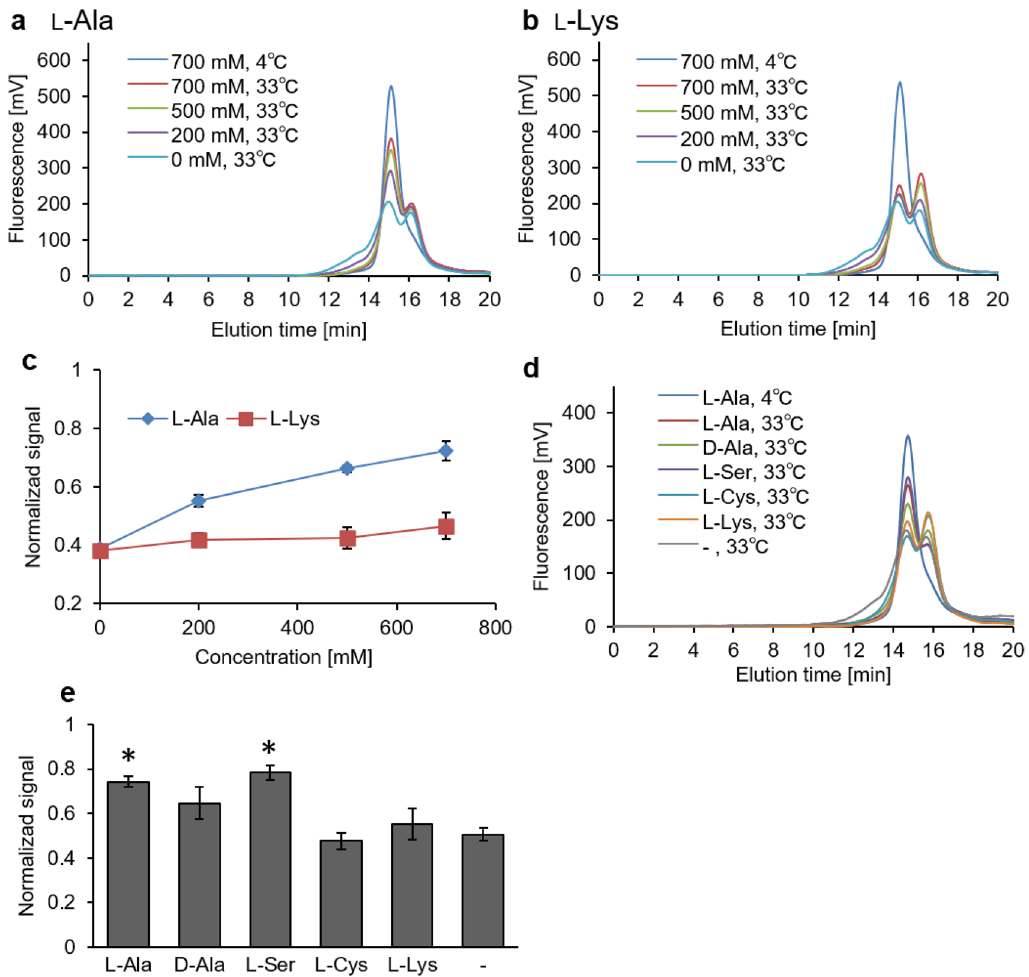
Figure 5. Low-affinity substrates need high concentrations to raise the thermal stability of AspT. Purified AspT was heat treated at 33°C for 10 min in the presence of 0 to 700 mM l-Ala ( a ) or l-Lys ( b ). After ultracentrifugation at 190,000 g for 30 min at 4°C to remove aggregated AspT, the supernatant was subjected to size-exclusion chromatography and the tryptophan fluorescence of AspT was observed with a fluorescence detector. Relative fluorescence intensities of undenatured AspT, taking the peak height of purified AspT without heat treatment as 1, are shown in ( c ). ( d ) Purified AspT was heat treated at 33°C for 10 min in the presence of 700 mM substrate or analog. Relative fluorescence intensities of undenatured AspT, taking the peak height of purified AspT without heat treatment as 1, are shown in ( e ). * P < 0.05, Tukey’s which showed l-Ala binding conformation (Figs. 1 and 2), led to slightly greater thermal stability than that of free AspT (Fig. 5d-e). These results indicate that the l-Asp binding conformation and the l-Ala binding confor- mation have different thermal stabilities, and that the l-Asp binding conformation is thermodynamically more stable than the l-Ala binding conformation. A similar phenomenon has been reported in the mitochondrial ADP/ATP carrier: A difference between specific conformations has been demonstrated by measuring the effect of mutations on the thermal stability of detergent-solubilized carriers locked in a specific state 16 . The observed difference between l-Asp concentration dependency and l-Ala concentration dependency in FSEC-TS was in good agreement with the results reported for the substrate affinity of AspT: AspT has a lower K m value in the presence of l-Asp (0.35 mM) than of l-Ala (26 mM) 12 . Moreover, in the OGM labeling assay, l-Asp induced conformational alteration of AspT at a lower concentration than did l-Ala (Fig. 1). Overall, fixation of confor- mation as a result of substrate binding contributed to the increase in thermal stability of AspT in the FSEC-TS experiment. Under physiological conditions, AspT couples with AspD, an intracellular aspartate decarboxylase, to accomplish l-Asp:l-Ala conversion; AspT takes up extracellular l-Asp into the cell, and AspD decarboxylates